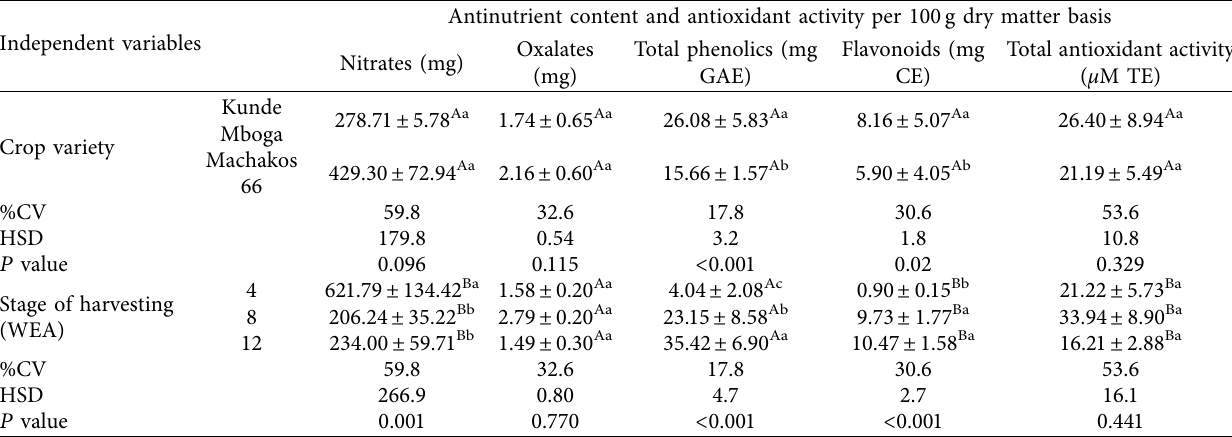
Table 9: Main efect crop variety and stage of harvesting on the antinutrient and antioxidant contents of cowpea leaves. Independent variables